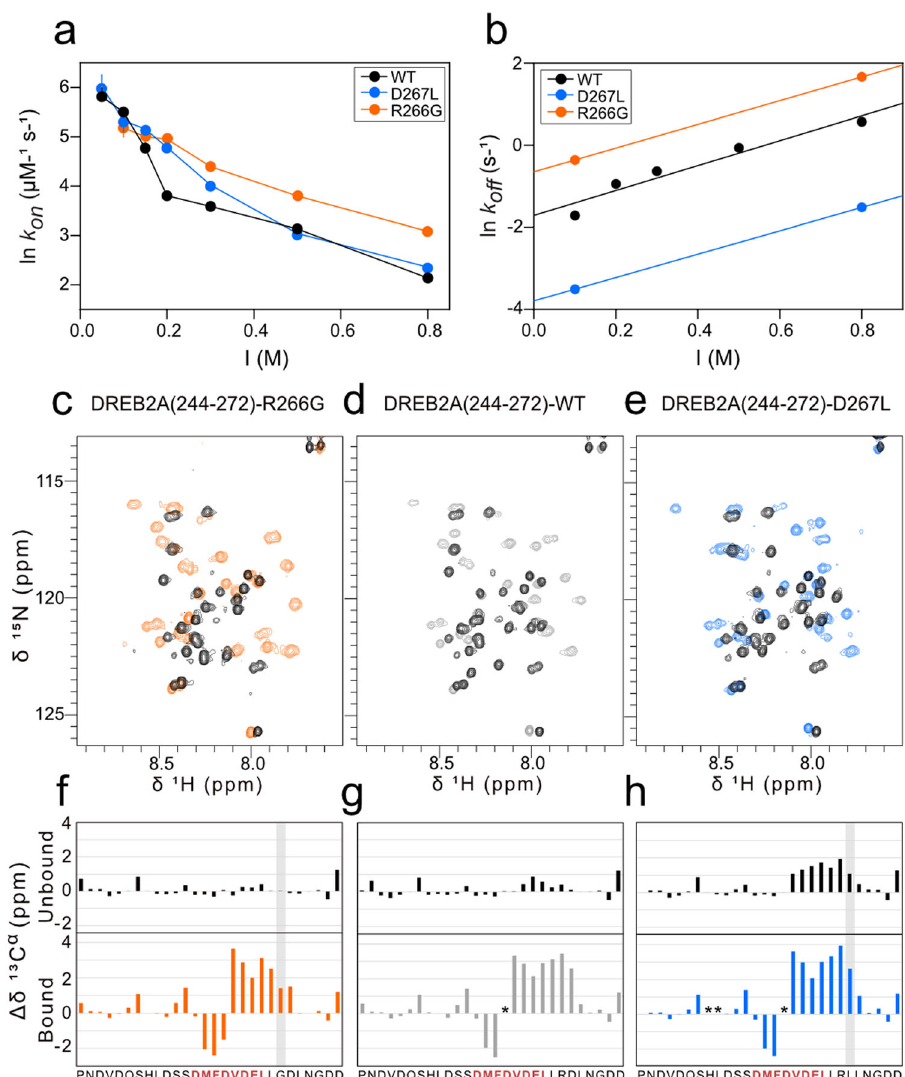
Fig. 2 DREB2A(244-272) variants WT, R266G and D267L and their interactions with RCD1-RST(499-572). a , b Analysis of the role of electrostatics in RCD1-RST(499-572) binding to DREB2A(244-272) variants WT (black), R266G (orange), and D267L (blue) from stopped- fl ow spectroscopy at 10 °C, 50 mM HEPES pH 7.4, and varying salt concentrations. Error bars represent standard error from fi t. Raw data available as Supplementary Data 1. a Association kinetics obtained at 50-800 mM NaCl and b dissociation kinetics at 100-800 mM NaCl. c – h Secondary structure analysis of DREB2A variants from NMR analyses with overlayed 1 H, 15 N HSQC spectra of 13 C, 15 N-labeled DREB2A(244-272)-R266G ( c ), DREB2A(244-272)-WT ( d ), and DREB2A(244-272)-D267L ( e ) in free (black) and RCD1-RST(499-572)-bound states (colored). Secondary C α chemical shifts for f DREB2A(244-272)- R266G, g DREB2A(244-272)-WT, and h DREB2A(244-272)-D267L in its free (upper panel, black) and RCD1-RST(499-572)-bound (lower panel, colored) states. The mutated positions are highlighted (gray bar). The SLiM region (red letters) and residues that could not be assigned (star) are indicated. Raw data available as Supplementary Data 2. Table 1 Kinetic parameters and K d values for DREB2A(244-272) variants binding to RCD1-RST(499-572). Interaction